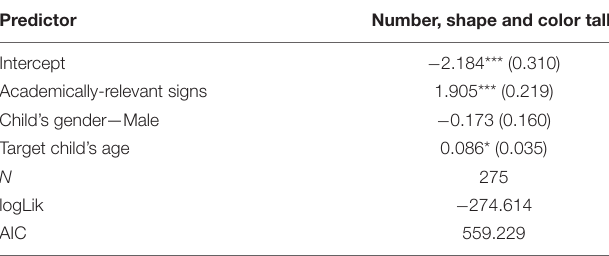
TABLE 1 | Results of the fixed-effects factors of the Poisson regression predicting the number, color and shape talk across the two signs-up categories.